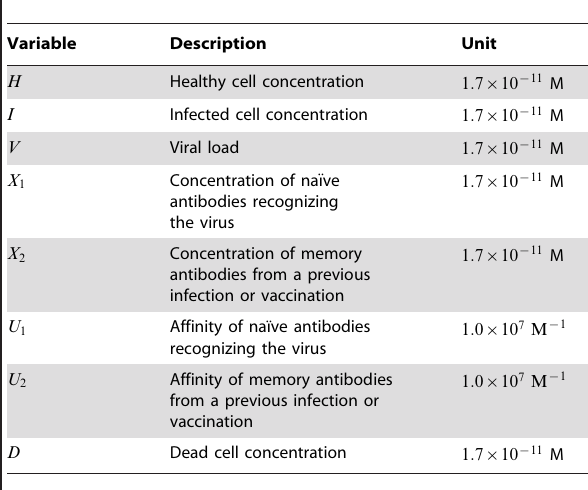
Table 1. Descriptions and units of the variables of the dynamical